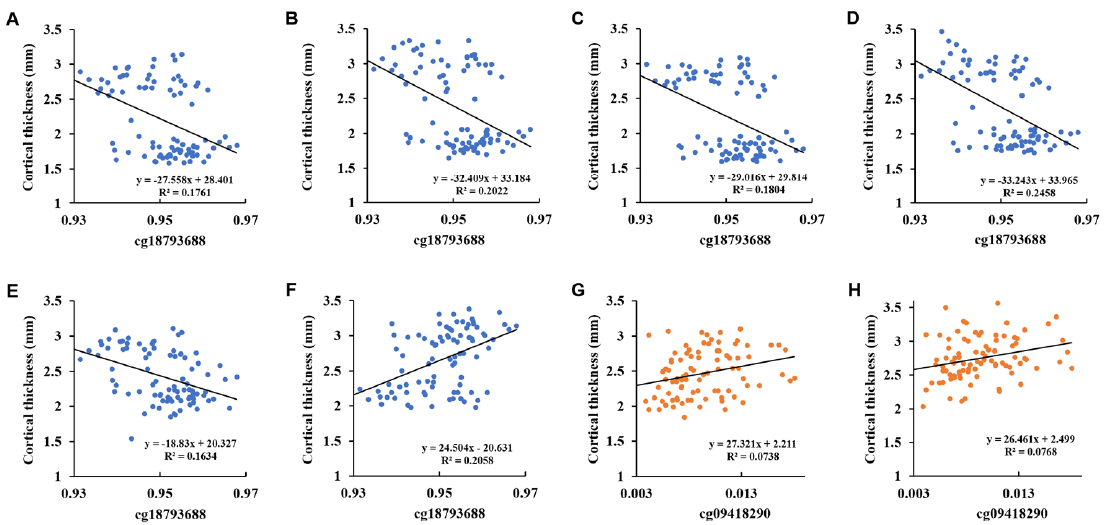
Figure 1. The lower panel shows scatter plots of the correlation analyses between cortical thickness and methylation scores of cg18793688 ( A – F ) and cg09418290 ( G – H ) in the MDD group on the cortical regions, which showed significant thickness differences between the MDD and HC groups (( A )—left cuneus; ( B )—left lingual gyrus; ( C )—right cuneus; ( D )—right lingual gyrus; ( E )—right postcentral gyrus; ( F )—right middle temporal gyrus; ( G )—left superior occipital gyrus; ( H )—right planum temporale). The upper panel shows schematic maps based on the Destrieux atlas regarding the cortical regions, with significant correlations between their thickness and the methylation scores of cg18793688 and cg09418290 in MDD group. The letters ( A – H ) represent the corresponding cortical regions in the scatter plots.